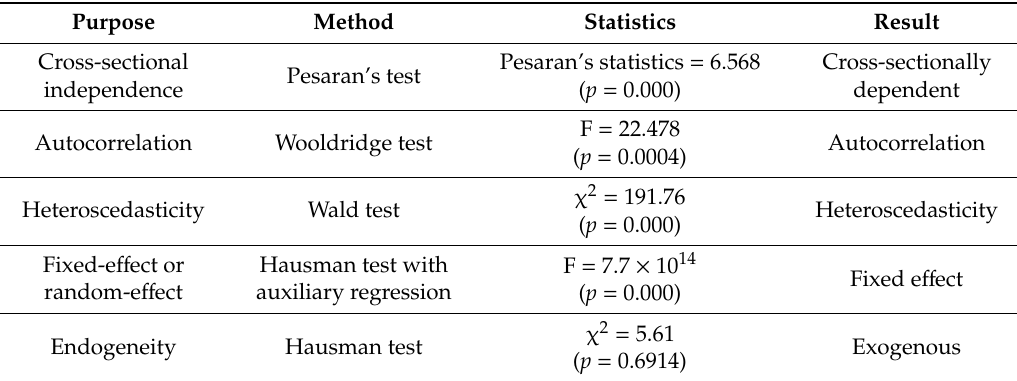
Table 2. Results of relevant